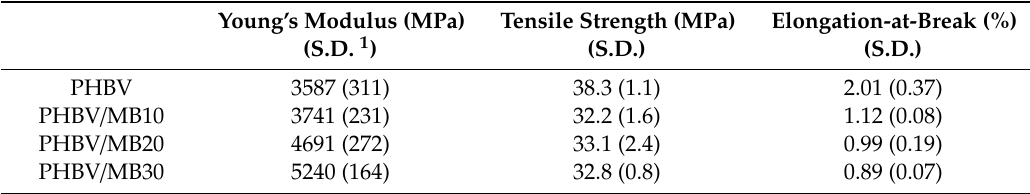
Table 1. Tensile properties of the PHBV and its biocarbon composites.